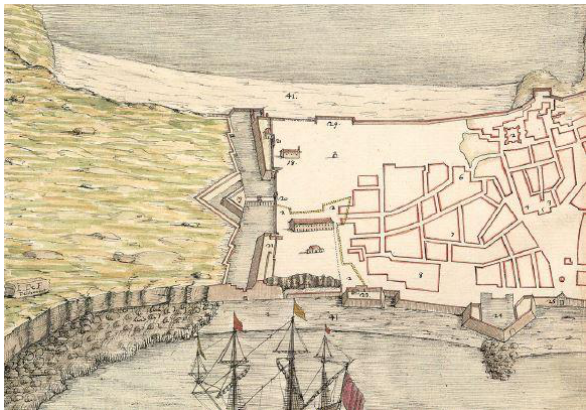
Figure 5. Detail of the Puerta Tierra in the representation of the Cadiz plant, between 1650 and 1655, belonging to the collection of plants of Spanish cities of the Marquis de